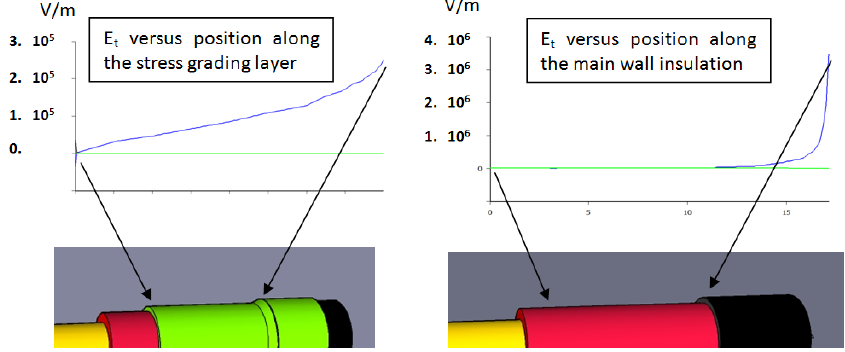
Figure 22. Simulations associated to case ( a ) and ( b ) show that electrical field at the end of the Conductive Armor Tape can be mitigated. Its value can be similar to the value encountered in the insulating layer which is in the slot (1.0 × 10 6 V/m = 1 kV/mm). Therefore, the electrical ageing in this sensible area is similar to the electrical ageing in the slot (case (b)).